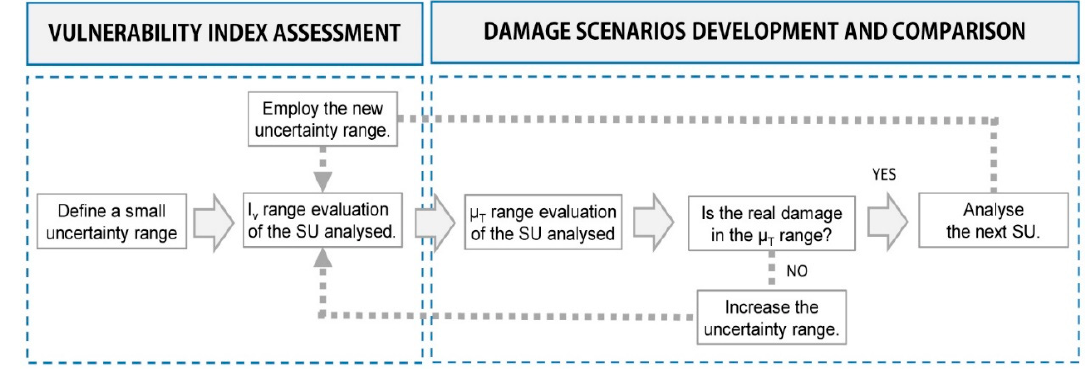
Figure 20. Step by step procedure for the LC definition of each confidence class.